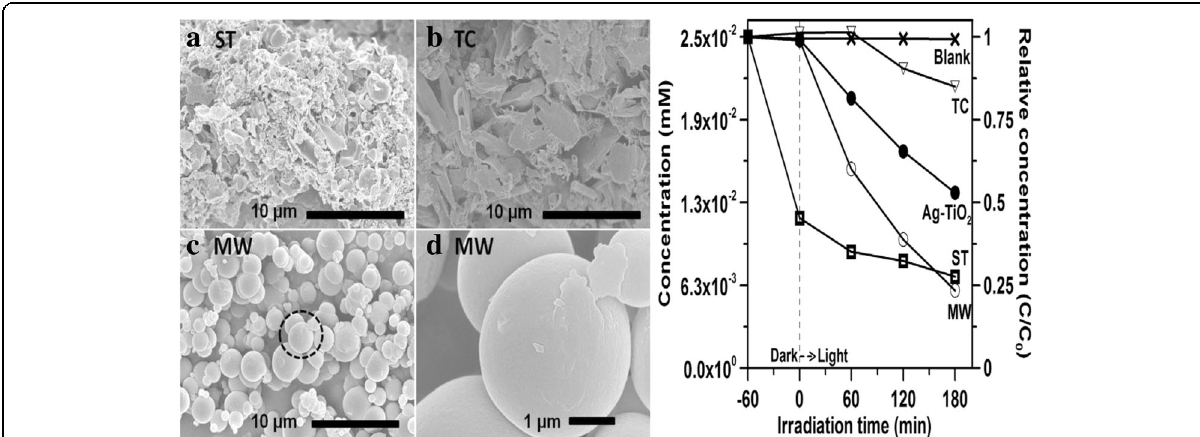
Fig. 11 SEM images of (a) ST, (b) thermal condensation (TC), and (c) Microwave assisted synthesis (MW) samples; (d) magnification of MW sample; Photocatalytic degradation of MO solution over MW, ST, TC C3N4, and Ag-TiO2 samples irradiated under visible light. In the experiment, a blank test was performed in which the solution was irradiated without adding a catalyst. Reproduced with permission [125]. Copyright 2017